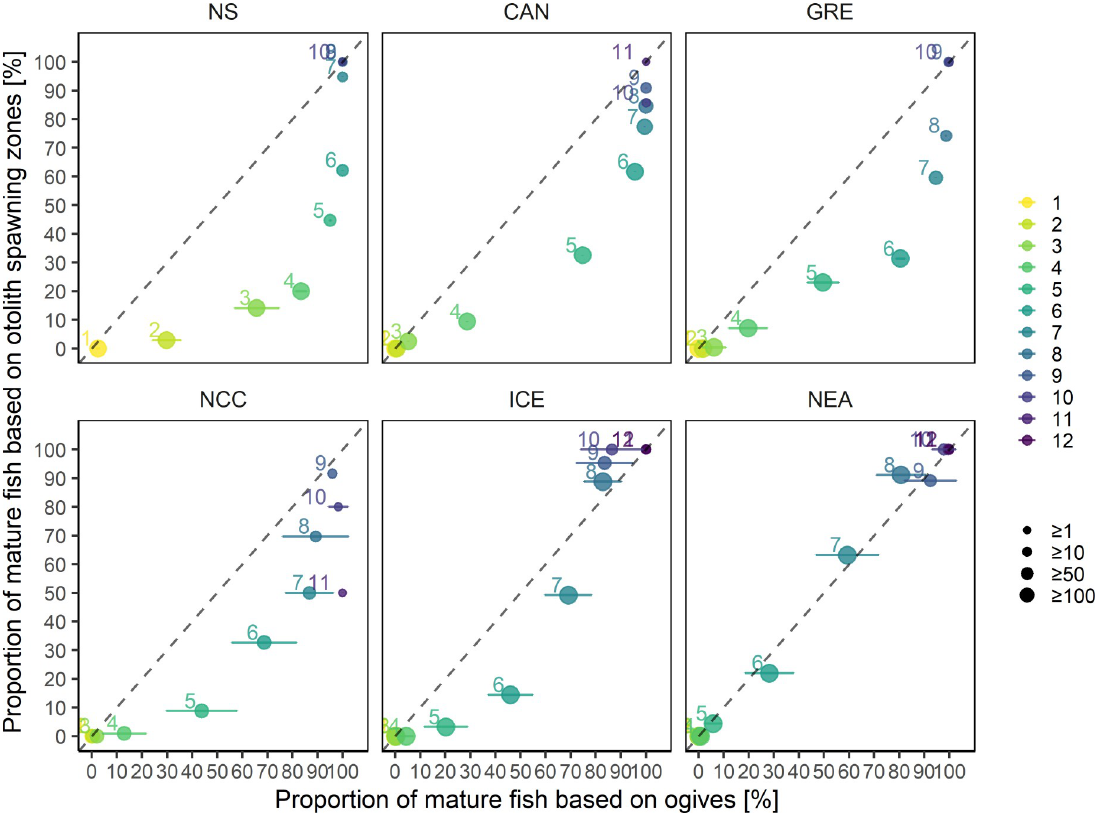
Fig 5. Proportions of mature at age (colors) calculated for each population from the visual identification of individual spawning zones, compared to the mean proportions of mature at age calculated from the maturity ogives for the period specific to each population. Horizontal bars indicate the standard deviation of the mean of each proportion mature at age over the range of years defining the samples. Point size is proportionate to the number of individual increments per age class.